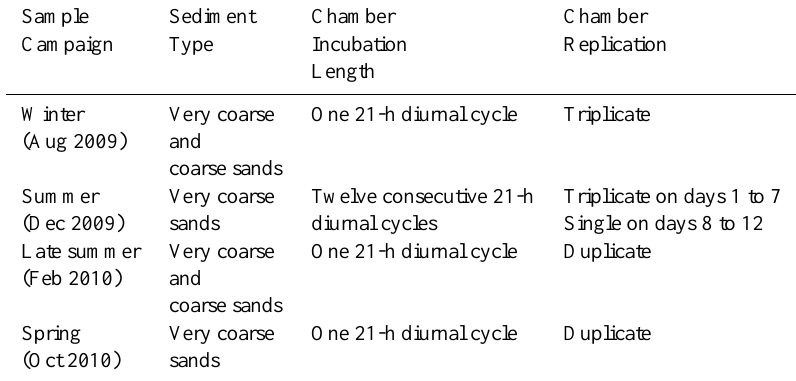
Table 1. Summary of benthic chamber sampling